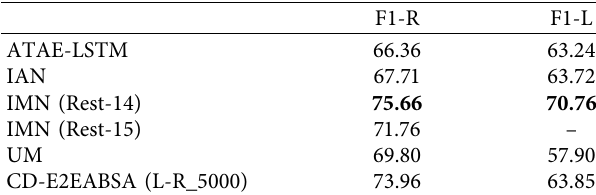
Table 3: The comparison results among different methods. Best scores are in bold, and second-best scores are